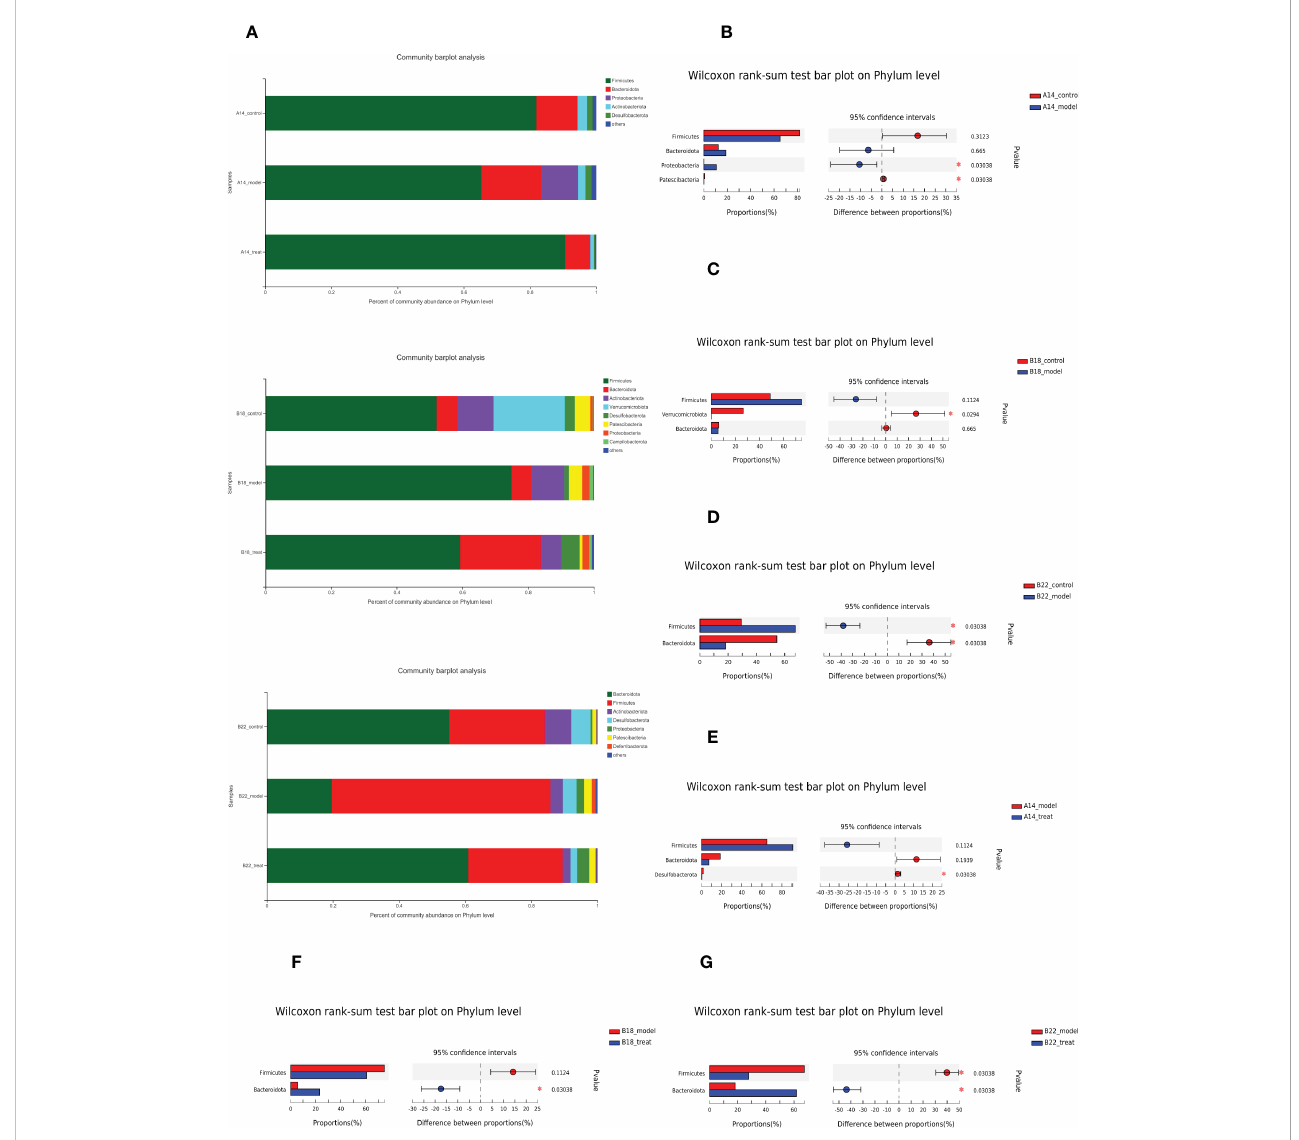
FIGURE 4 The effect of DAPA to dramatically restore the dysbiosis of db/db mice at the phylum levels enhanced over time. (A) Relative abundance of bacterial phyla, indicating changes in microbiota composition among three groups at 14 weeks (14w), 18 weeks (18w), and 22 weeks (22w). (B – D) Presentation of phyla with signi fi cant changes between the control group and model group at 14w, 18w, and 22w apart from dominant Firmicutes and Bacteroidota. (E – G) Presentation of phyla with signi fi cant changes between model group and model + DAPA group at 14w, 18w, and 22w besides dominant Firmicutes and Bacteroidota. N=4/group. Statistical signi fi cance was calculated using Wilcoxon rank-sum test. *p < 0.05. The treat group means model + DAPA